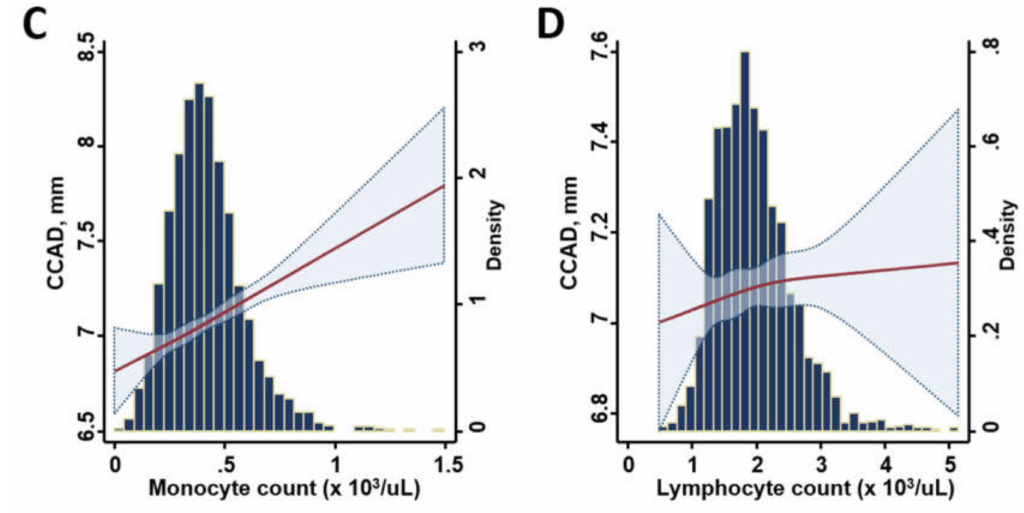
Figure 1. Restricted cubic splines (RCS) curves demonstrating the continuous relationship between white blood count fractions (including total WBC ( A ), segmented ( B ), monocyte ( C ), and lymphocyte counts ( D ) and common carotid artery diameter (CCAD). The y-axis displays the distribution and mean values of CCAD (mm).